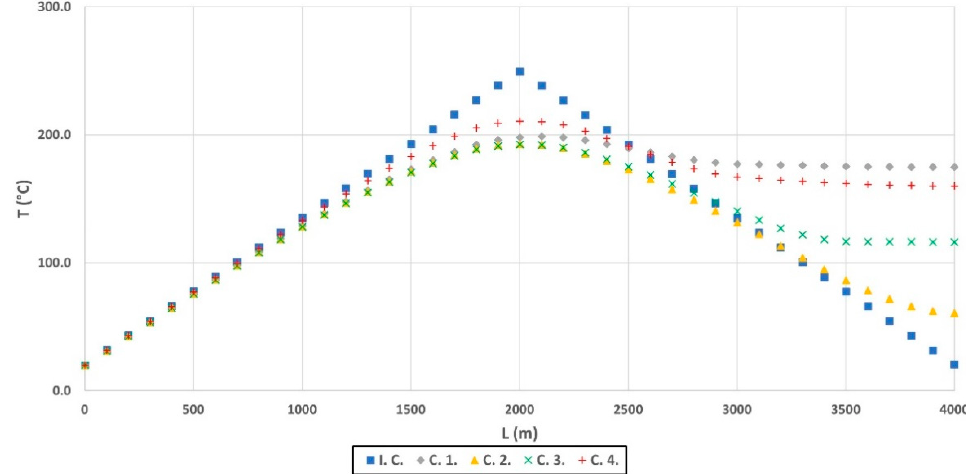
Figure 9. Fluid temperature inside the exchanger: I.C. initial condition (blue), C.1 (orange), C.2. (grey), C.3. (green), C.4. (red).